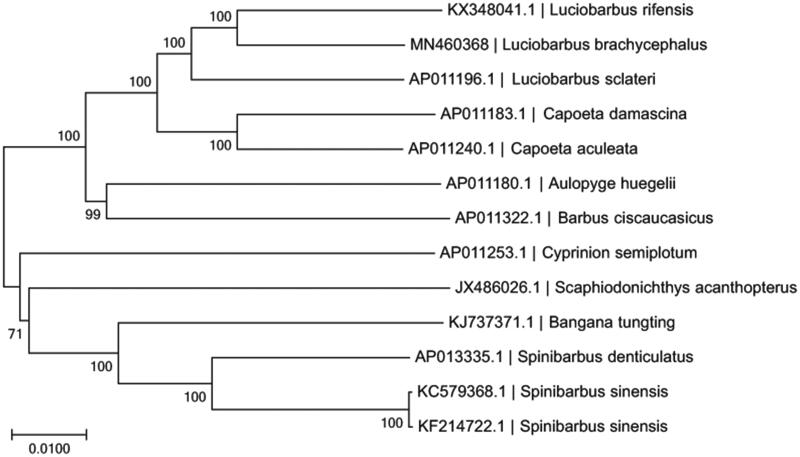
Phylogennetic analysis of L. brachycephalus based on the entire mtDNA genome sequences of 13 cyprinidae fish available in GenBank. Numbers above the nodes indicate 1000 bootstrap values. Accession numbers are shown before species names.